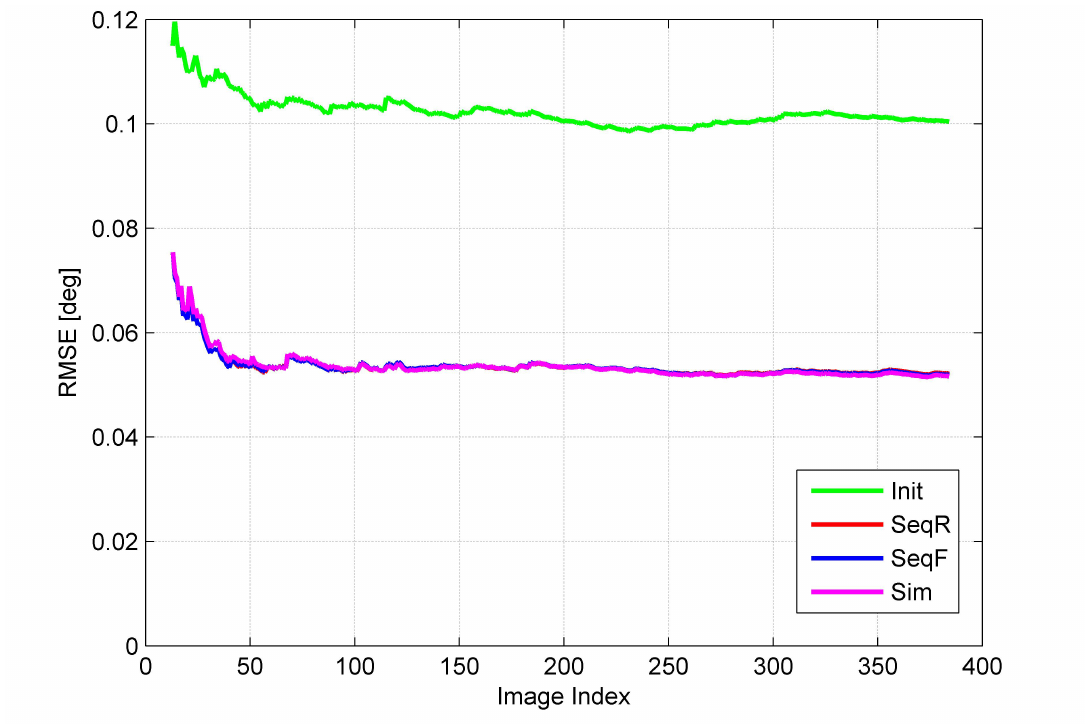
Figure 5. RMSE of estimated EOP